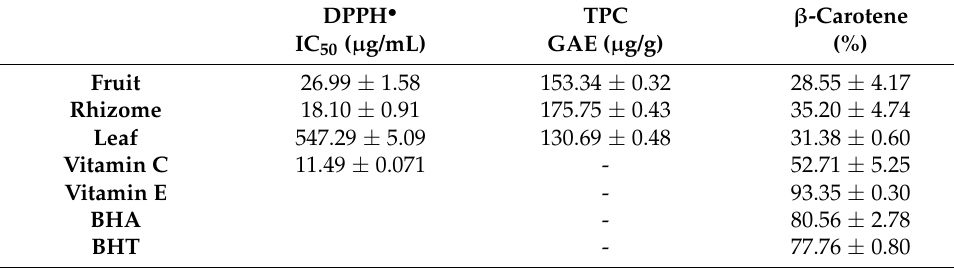
Table 3. Antioxidant activity of the Curculigo latifolia crude